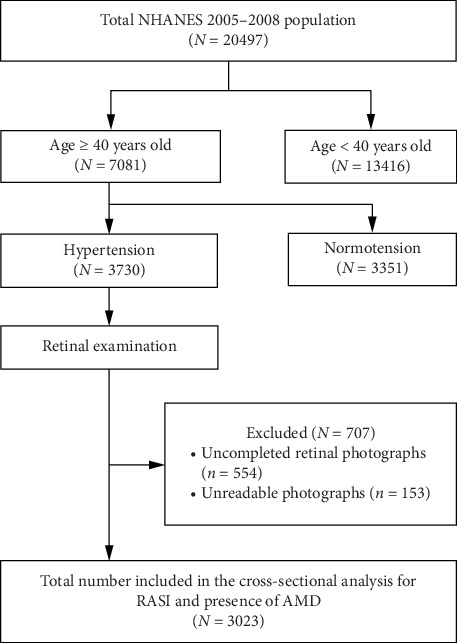
Population selection to obtain the final participants for assessment of the relationship between RASIs and AMD presence. NHANES: the National Health and Nutrition Examination Survey; RASI: renin-angiotensin system inhibitor; AMD: age-related macular degeneration.